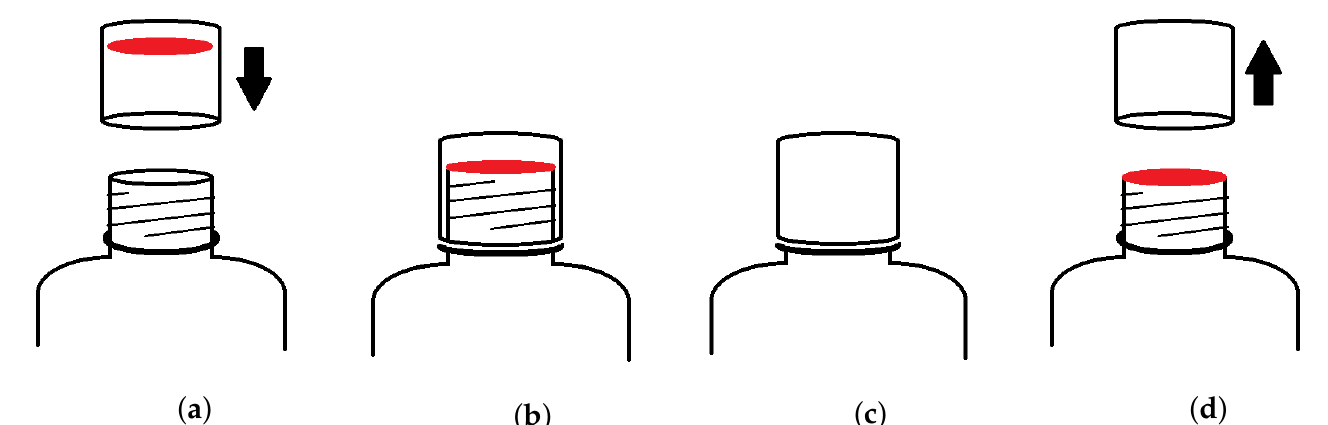
Figure 1. Details of the sealing process. ( a ) The plastic cap contains an aluminium sheet with glue. ( b ) After the bottle is capped, the aluminium circle is glued to the bottle opening. ( c ) Both the seal and the cap should remain in place until the bottle is opened for use. ( d ) Once the plastic cap is removed, the aluminium seal should remain in place until broken.